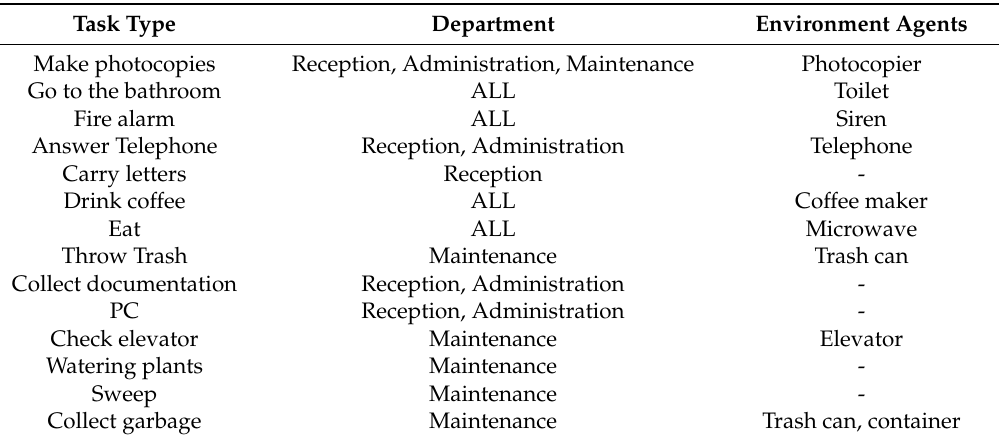
Table 1. Relations between tasks, departments and environment